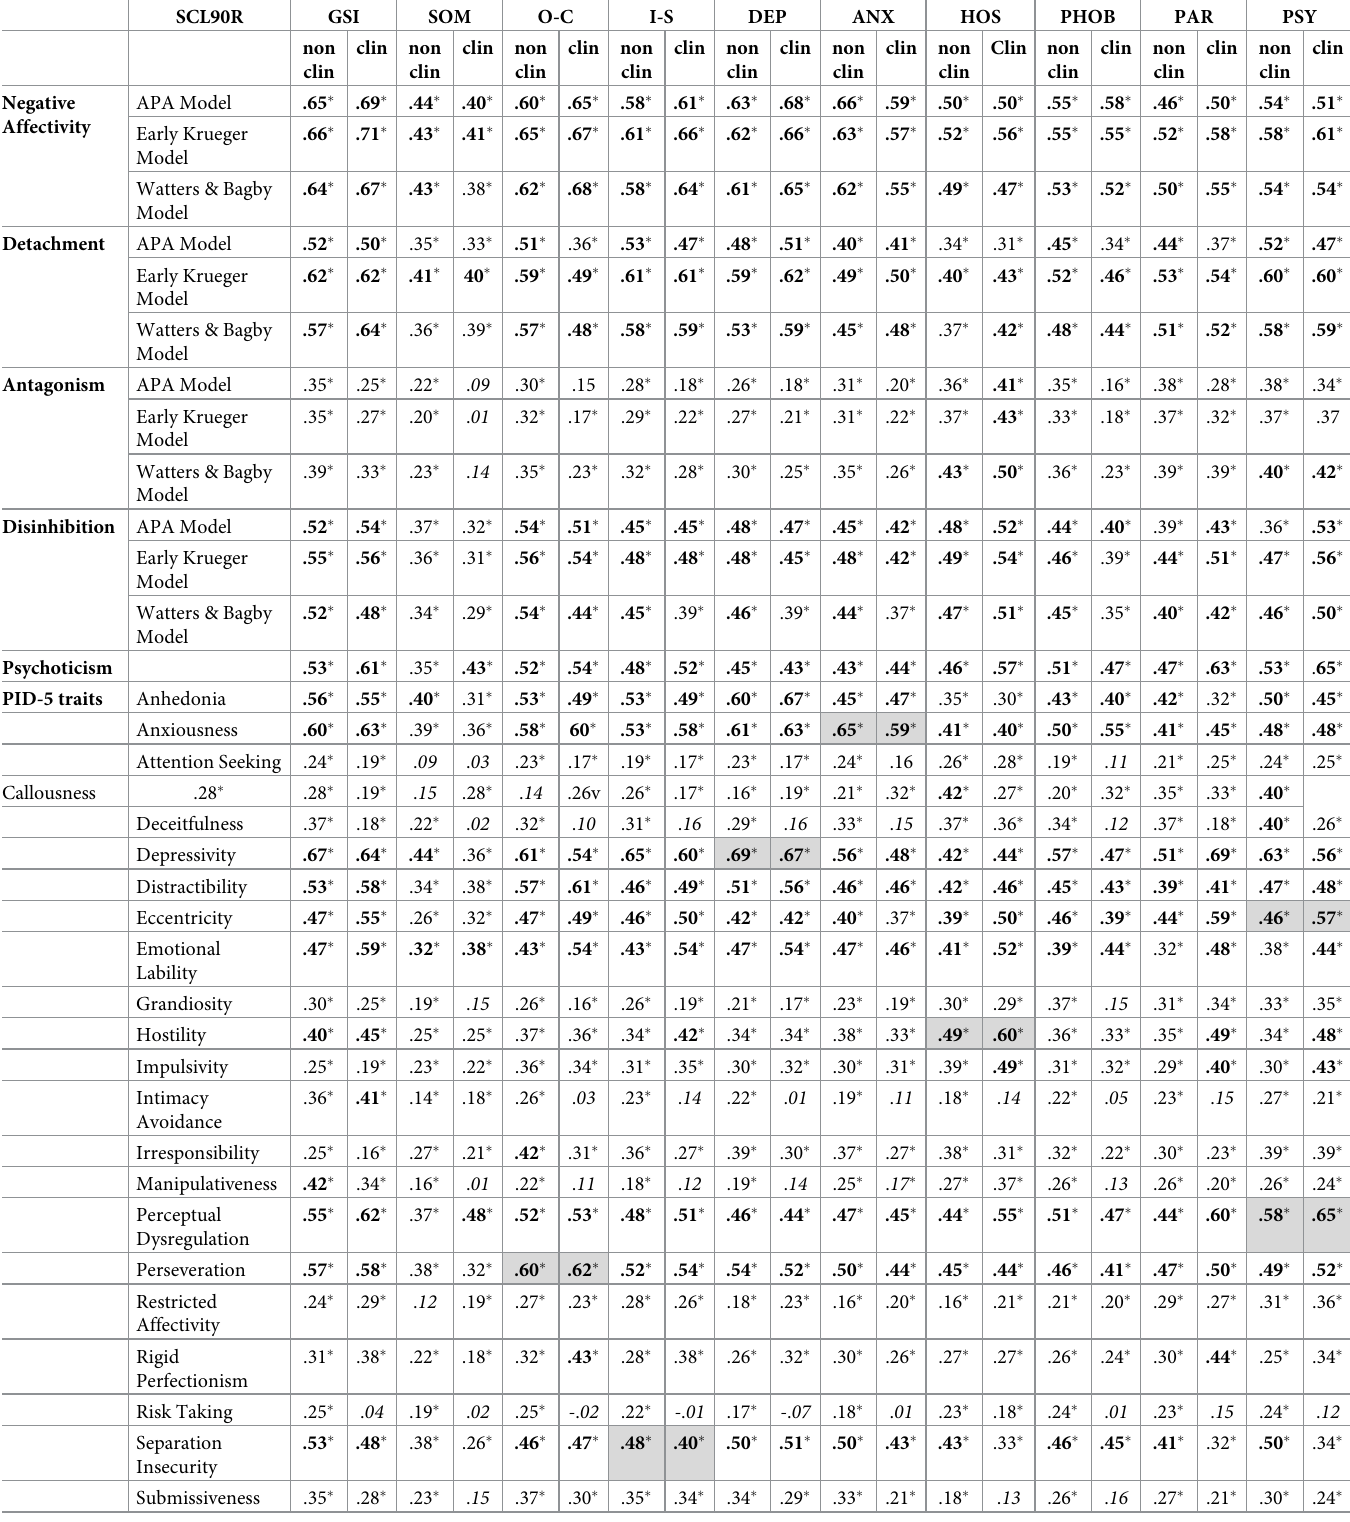
Table 7. Pearson correlations between PID-5 traits and SCL90-R scales. SCL90R GSI SOM O-C I-S DEP ANX HOS